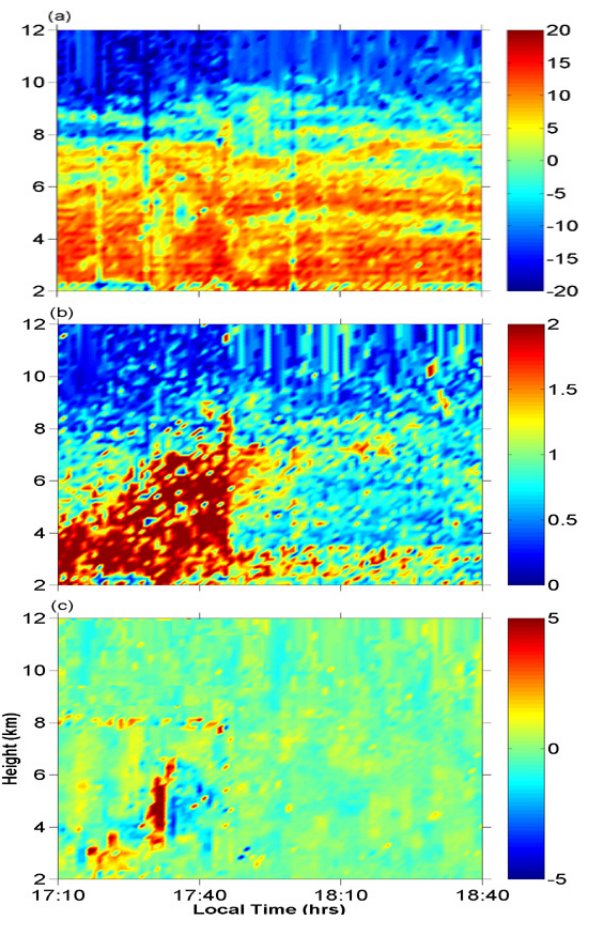
Fig. 3. Height time sections of (a) VHF radar signal-to-noise ratio (dB), (b) spectral width (m/s) and (c) vertical velocity (m/s) for a shallow convective system, as observed on 18 August 1999.